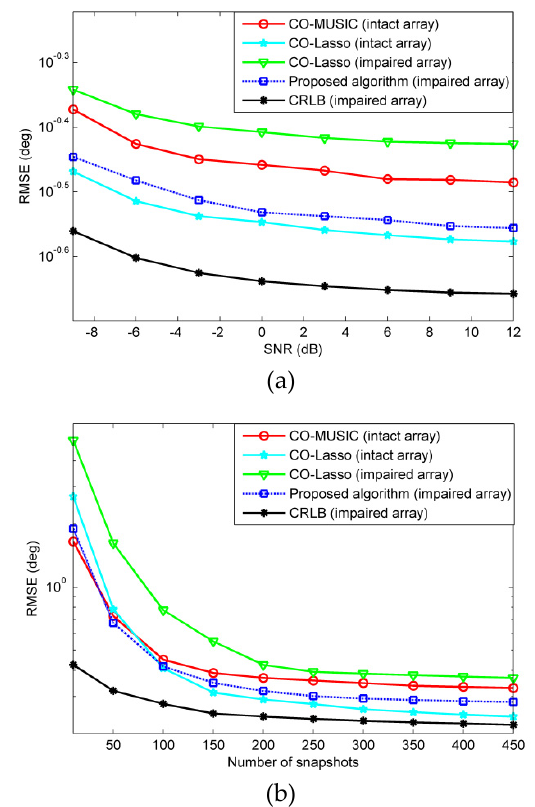
Figure 7. The scenario of non-redundant sensor failures, the RMSE performance comparison of CO-MUSIC, CO-Lasso, and the proposed method with 500 Monte Carlo trials and 18 sources considered. ( a ) RMSE versus SNR with L = 300 and ( b ) RMSE versus the number of snapshots with SNR = 0dB.